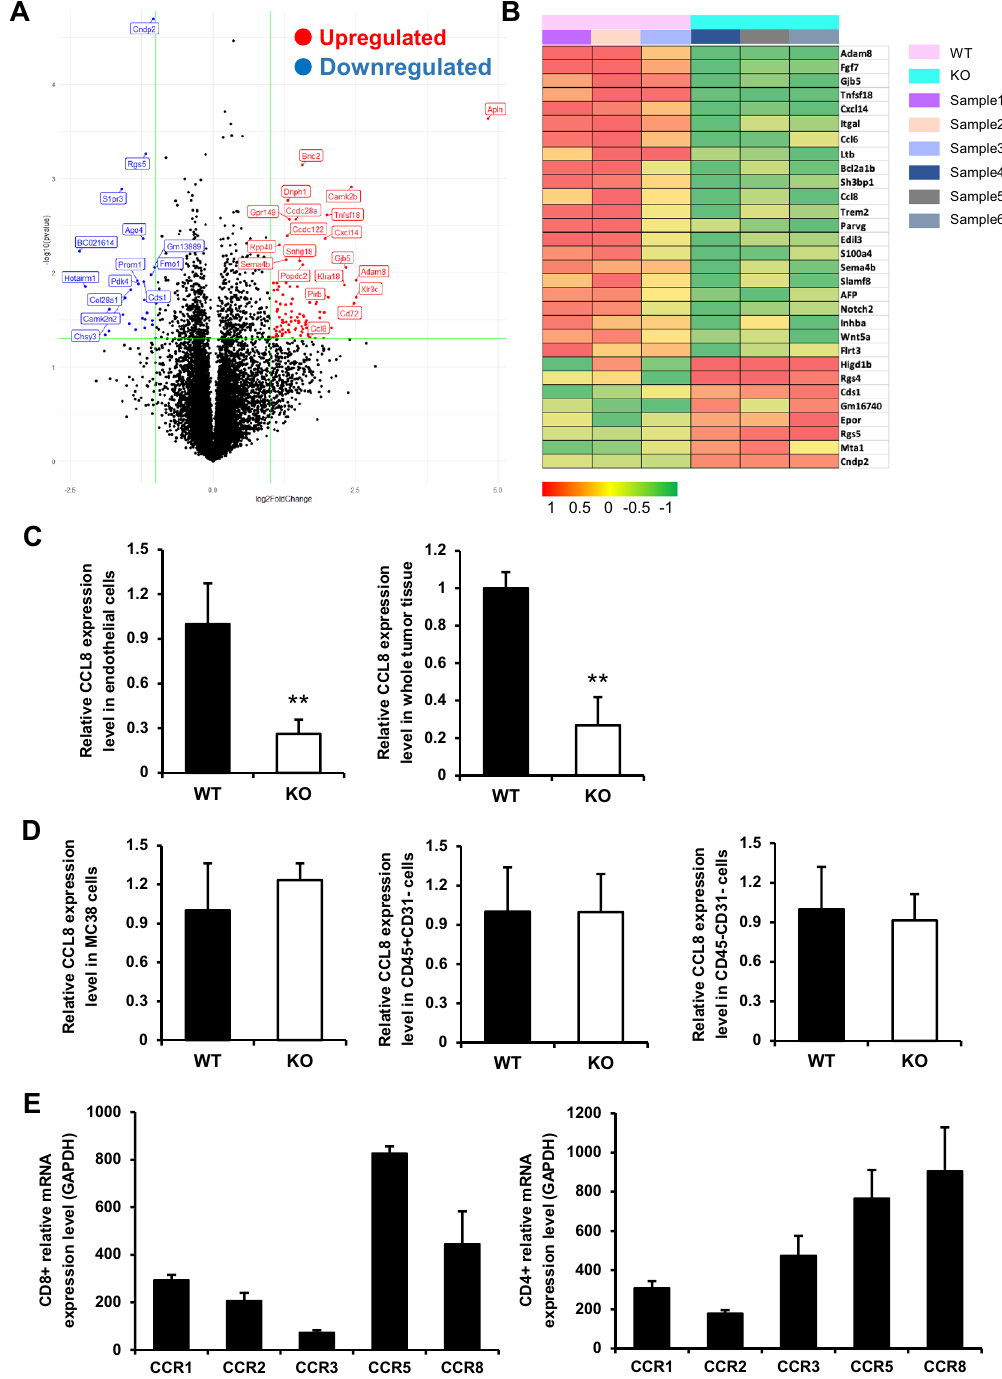
Figure 5. Global transcript expression levels of tumor endothelial cells analyzed by RNA sequencing. ( A ) Volcano plot of RNA-seq transcriptome data depicting gene expression patterns for ECs isolated from WT relative to Apelin-KO mice tumors at day 19 (n = 3 for each group). Volcano plot was illustrated by R 4.0.4 with packages ggplot2 and ggrepel. ( B ) Heatmap of 30 highly changed genes in ECs from WT or Apelin-KO mice bearing tumors (n = 3 for each group). Heatmap was drawn with log2 FPKM values. ( C ) qRT-PCR showing CCL8 expression levels in ECs and whole tumor tissue normalized to WT mouse tumor CCL8 expression. ( D ) qRT-PCR showing CCL8 expression levels in MC38 cancer cells, CD45 + CD31 − immune cells and CD45 − CD31 − stromal cells, respectively, normalized to WT mouse tumor CCL8 expression. ( E ) qRT-PCR of CCR expression levels in CD8 + and CD4 + T cells. The error bars indicate mean ± SD and all data were analyzed by two-sided Student’s t-test. **p <